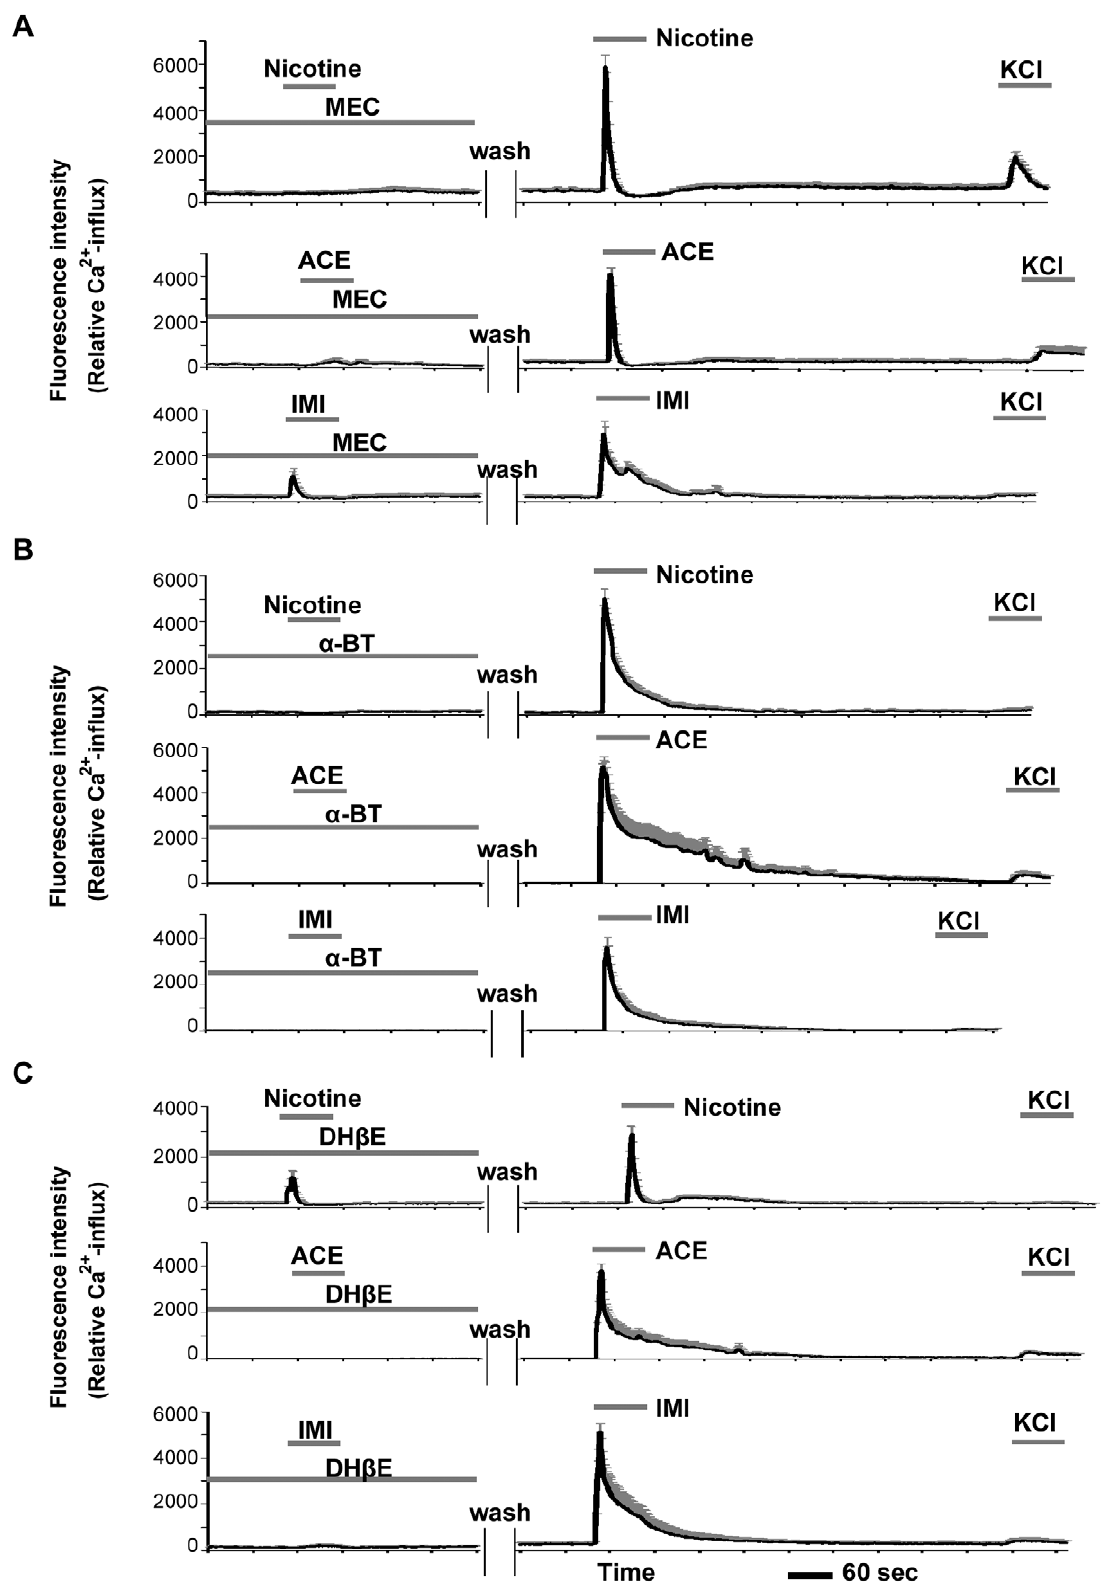
Figure 6. Effects of nAChR antagonists on Ca 2 + influxes induced by ACE, IMI, or nicotine. The antagonists MEC ( A , 100 m M), a -BT ( B , 1 m M), and DH b E ( C , 1 m M) all significantly inhibited the excitatory effects of nicotine, ACE, or IMI at 100 m M. MEC partially inhibited the IMI-evoked responses ( A ), and DH b E partially blocked the nicotine-evoked responses ( C ). The line graphs represent the mean 6 the S.E.M. of the Ca 2 + -influx-